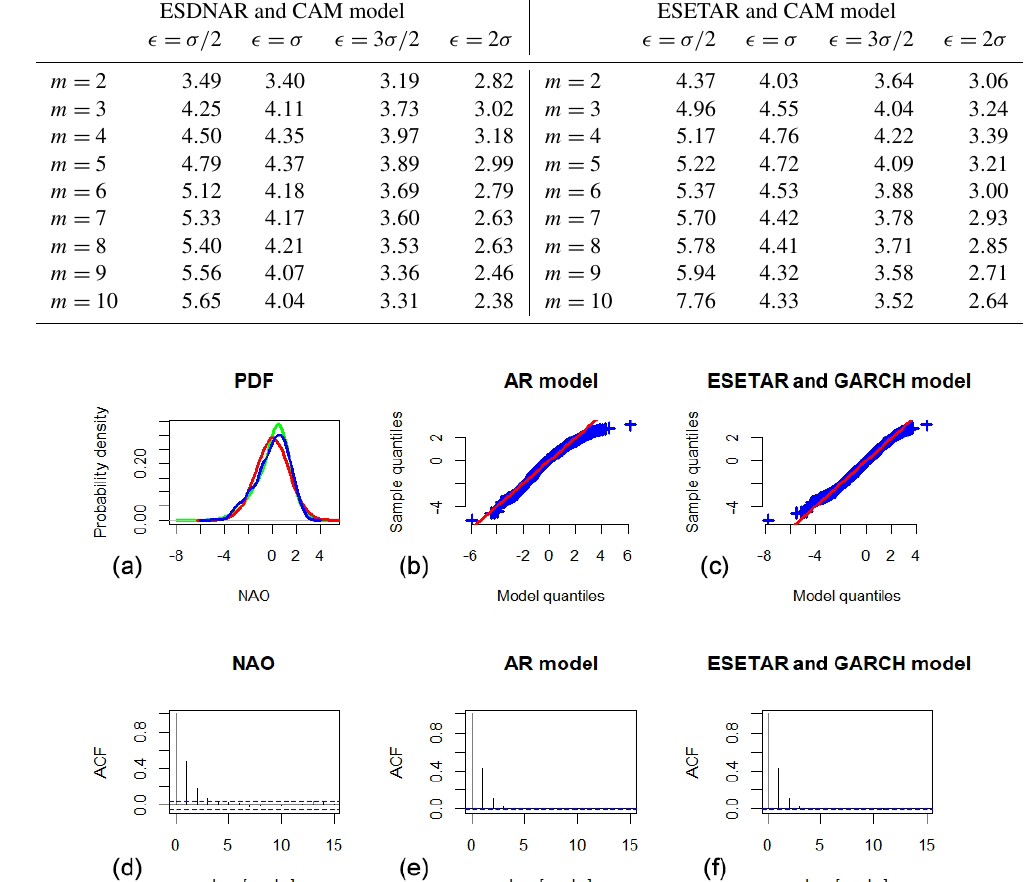
Figure 11. Simulation of weekly means of the NAO. Panel (a) shows the PDF of weekly means of the observed daily NAO winter index (blue) compared to weekly means of simulated NAO index obtained by the AR model (red) and the ESETAR model with GARCH noise, denoted as “ESETAR and GARCH model”, (green), respectively. Panels (a–c) are Q–Q plots of the weekly means of the daily NAO winter index compared to the simulated indices. Panels (d–f) show the sample ACF of weekly means of the observed daily NAO winter index (d) , the simulated index obtained by the AR model (e) and the simulated index obtained by the ESETAR model with GARCH noise (f) . Confidence intervals with confidence level 95% are indicated by dashed blue lines in the sample ACF